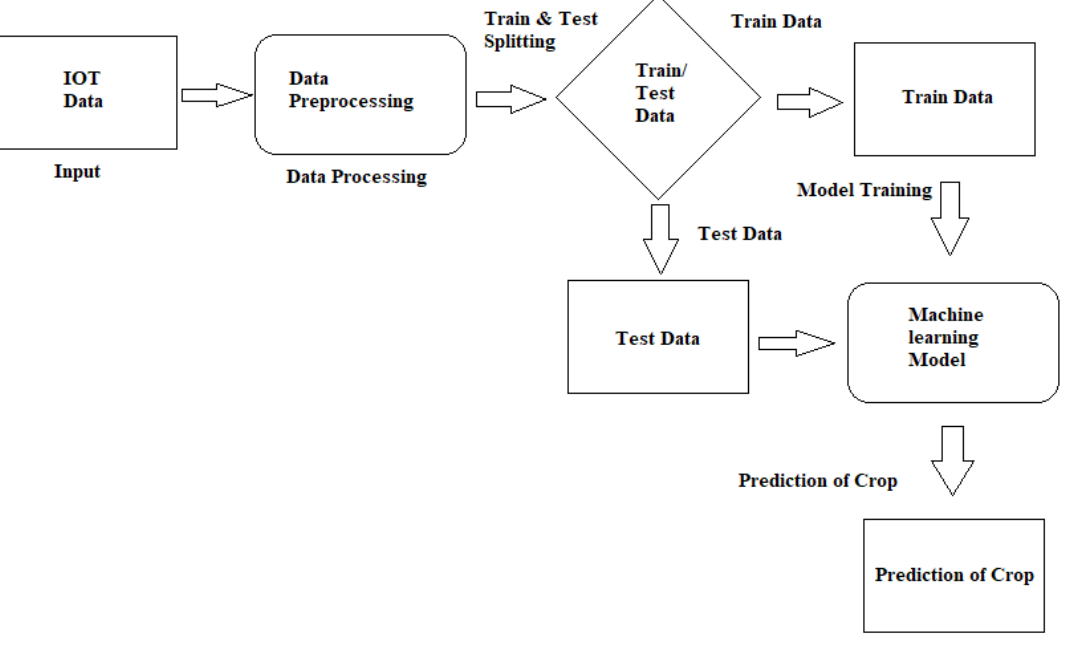
Figure 2. Flowchart for assessing expected crop yield. [113].